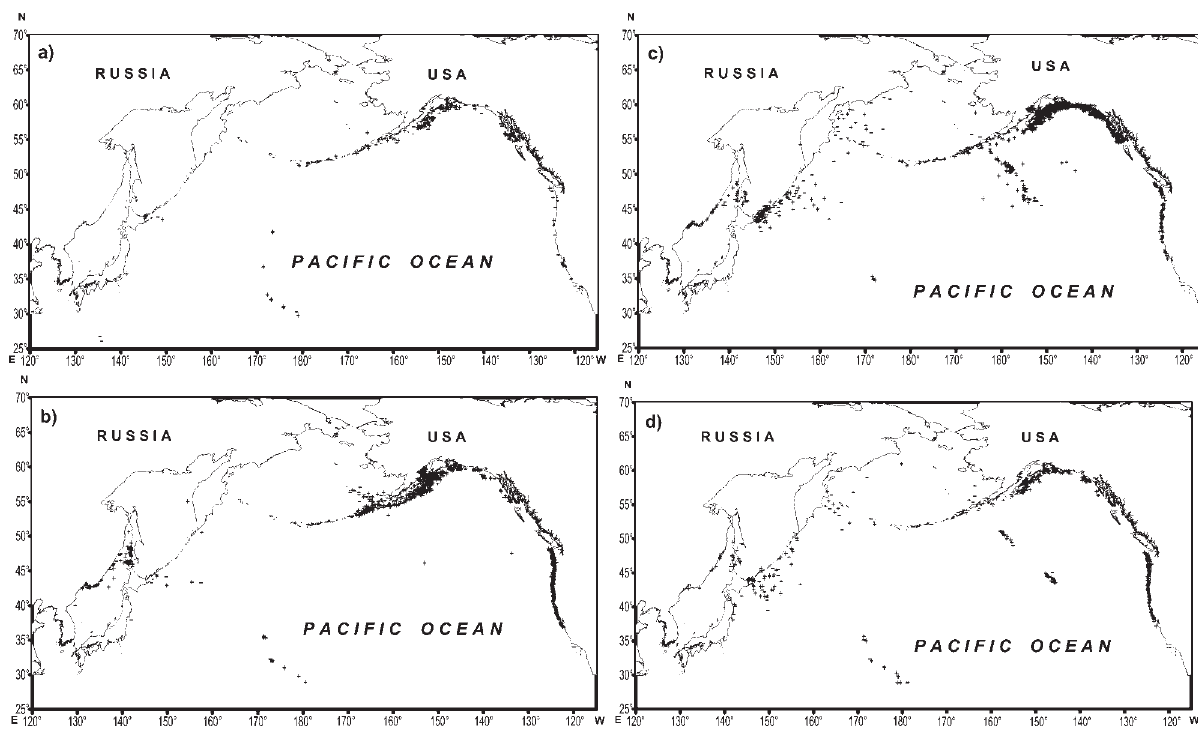
Fig . 3. – Capture sites of Squalus suckleyi in the North Pacific by seasons, 1970-2008: January-March (a), April-June (b), July-September (c), October-December (d).